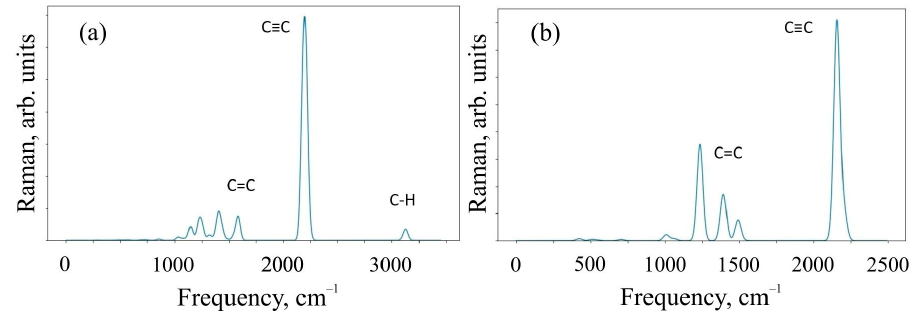
Figure 4. Raman spectra of ( a ) O1 oligomer and ( b ) 6,6,12-graphyne